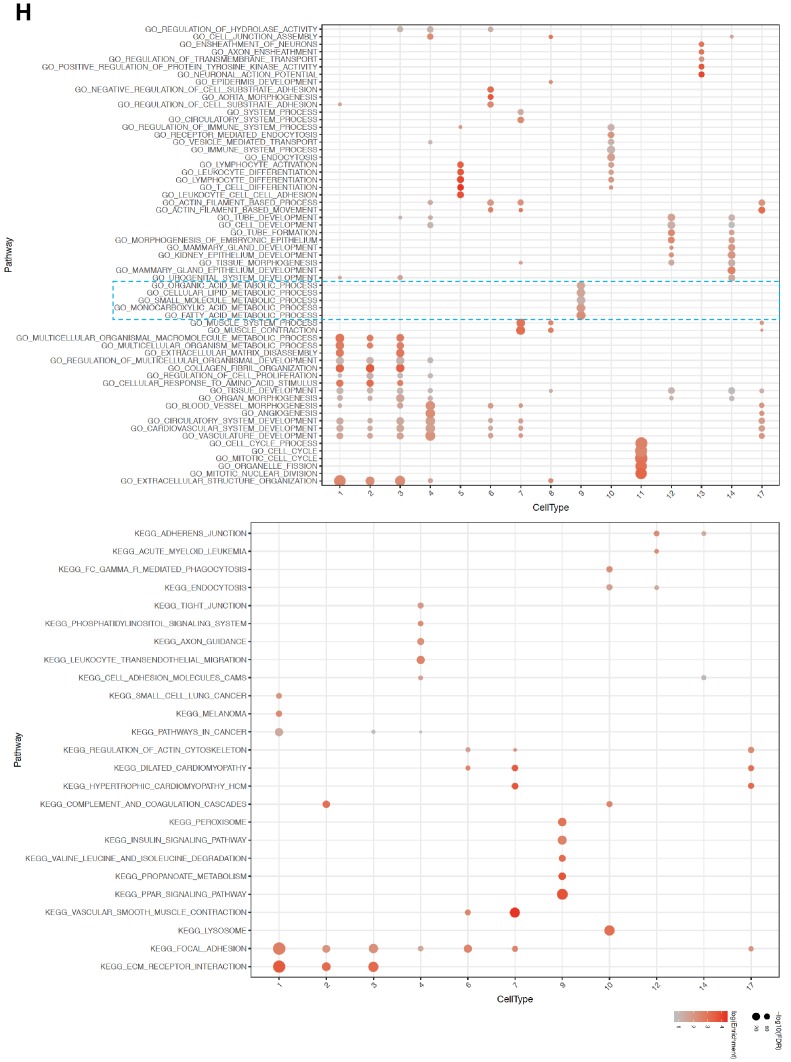
Enrichment of cells involved in lipid mobilization in Cluster nine adipocytes.(A and B) Gene set pathways obtained from GO Biological Processes and KEGG were used to find the functions of the different cell types. The top five enriched pathways determined by FDR from each cell type cluster were selected (from Supplementary file 1) and only unique pathways were kept (some top enriched pathways were shared across cell type clusters). Enriched pathways (rows) were clustered with hierarchical clustering. The size of each dot represents the -log10 FDR of the pathway enrichment and the color of each dot corresponds to the fold enrichment of each pathway (red- higher enrichment, gray- lower enrichment). Dotted blue squares highlight pathways enriched in cluster 9.